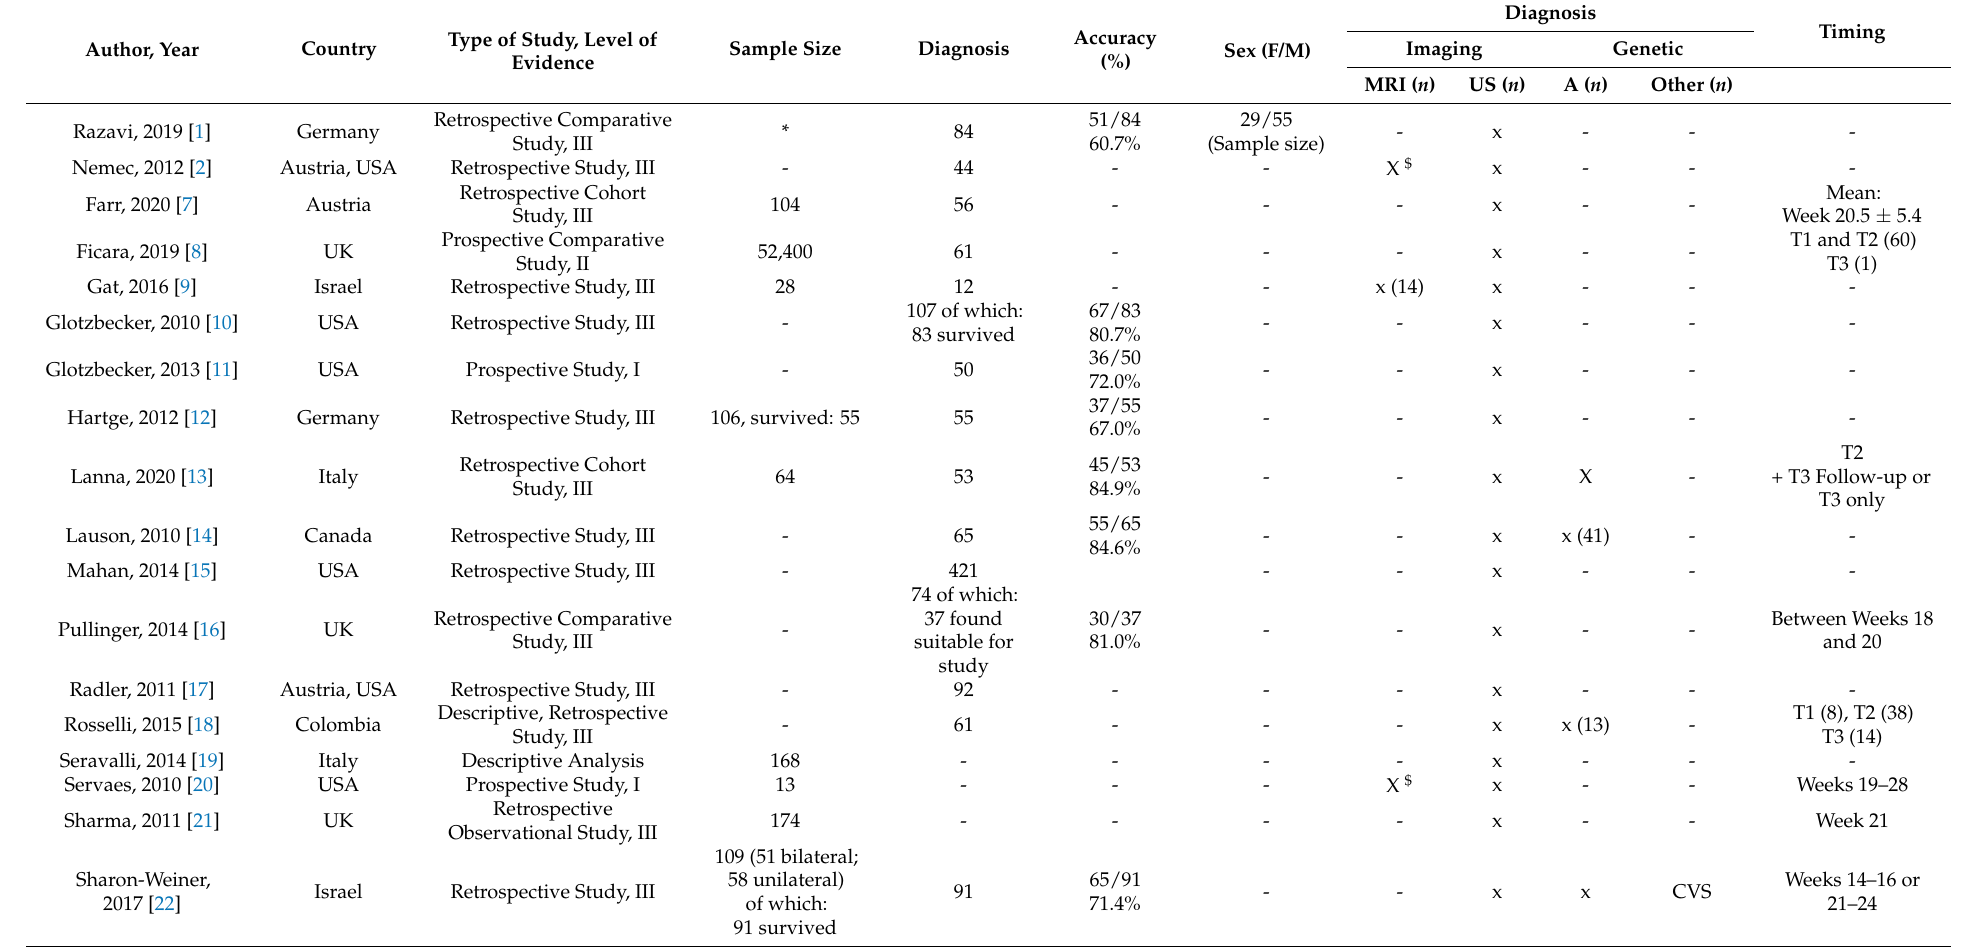
Table 1. Primary author, year of publication, country, type of study, level of evidence (LOE), sample size, diagnosis, accuracy, sex, type of diagnosis and timing of the studies